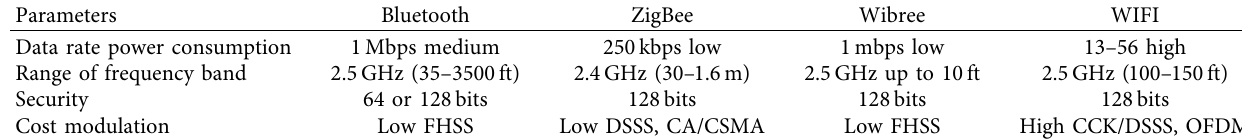
Table 5: Communication technologies in modern